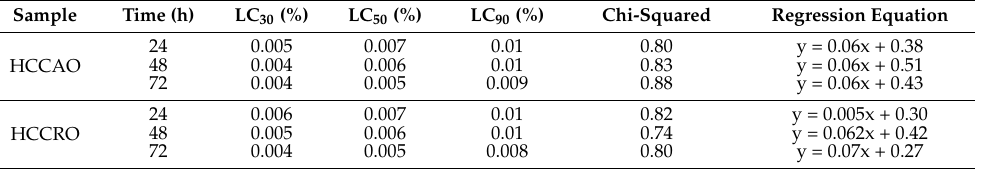
Table 7. LC 30 , LC 50 , and LC 90 value for insecticidal activity of HCCRO and HCCAO against S. litura